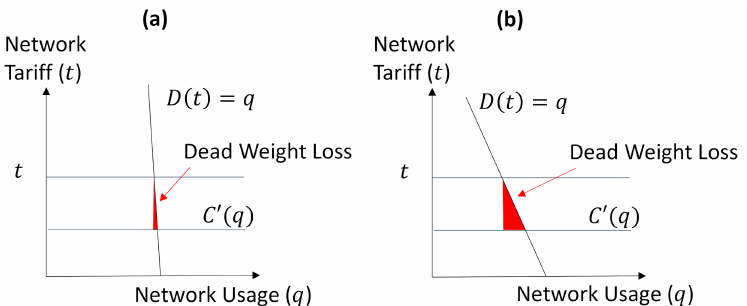
Figure 1. The e ff ect of network demand elasticity on market e ffi ciency when tari ff s are not aligned to network costs. The graphs represent the demand for network usage and as a function of the network tari ff . ( a ) DWL is small when demand is inelastic; ( b ) DWL is large when demand is elastic. Note that this intuition holds for long-run demand for network capacity and long-run marginal cost for network capacity (as sketched here) as well as for the short-run situation where we look short-run marginal costs of network